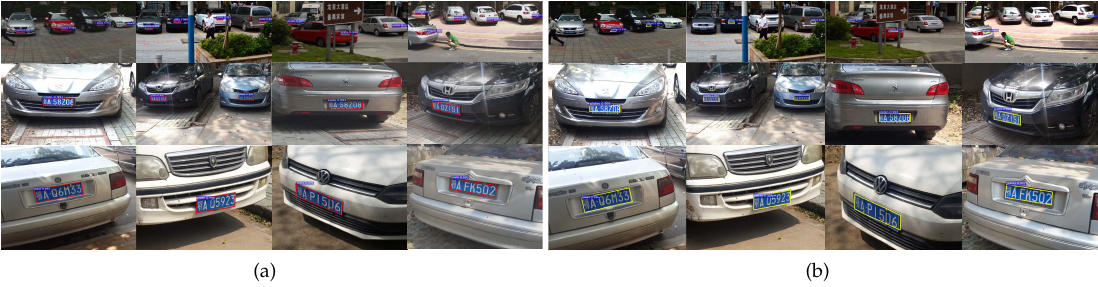
Figure 6. Some representative detection results: ( a ) our MOSI-LPD ; ( b ) MO-LPD . In each subfigure, license plates in the first to the last row were tiny, medium, and large, respectively. Our MOSI-LPD is more invariant to the scale discrepancy of license